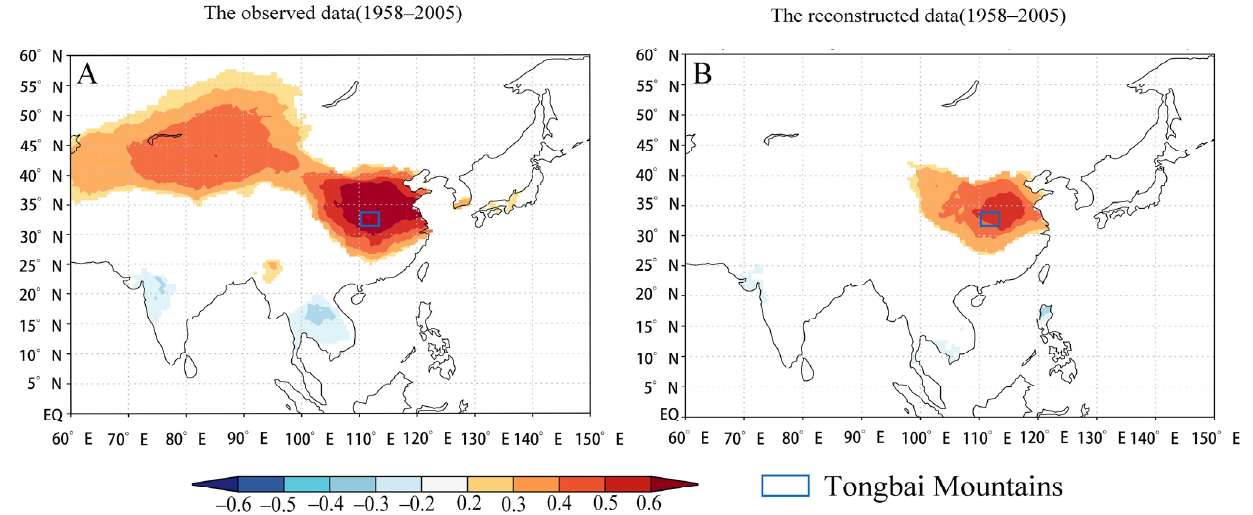
Figure 10. Spatial correlation between the observed ( A ) and reconstructed ( B ) T MJ with CRU TS 4.05 (0.5° × 0.5°) from 1958–2005 through the KNMI climate detector, which was used in order to study the regional representativeness of the reconstructed series in China.